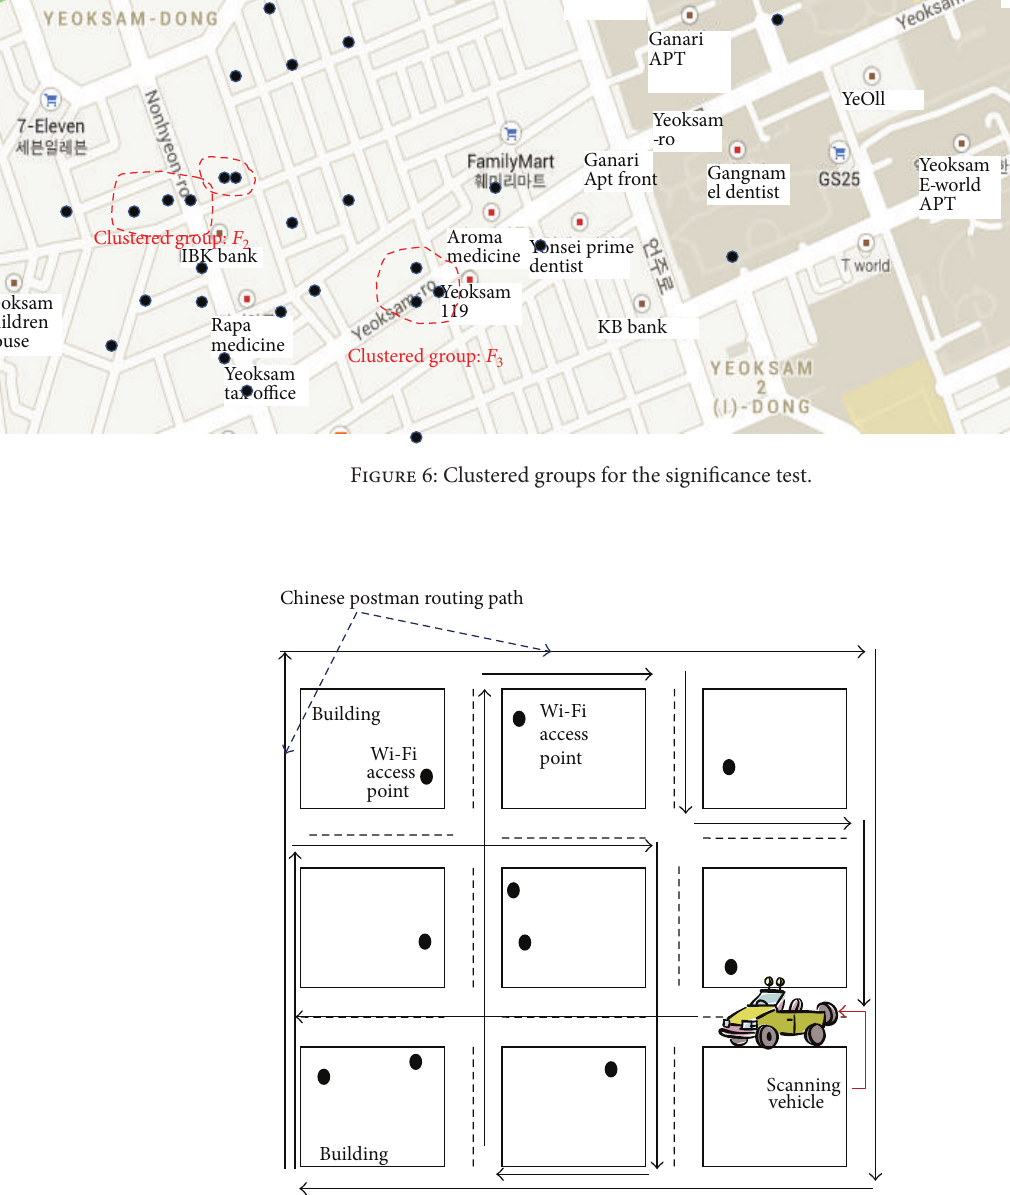
Figure 7: Scanning of RF